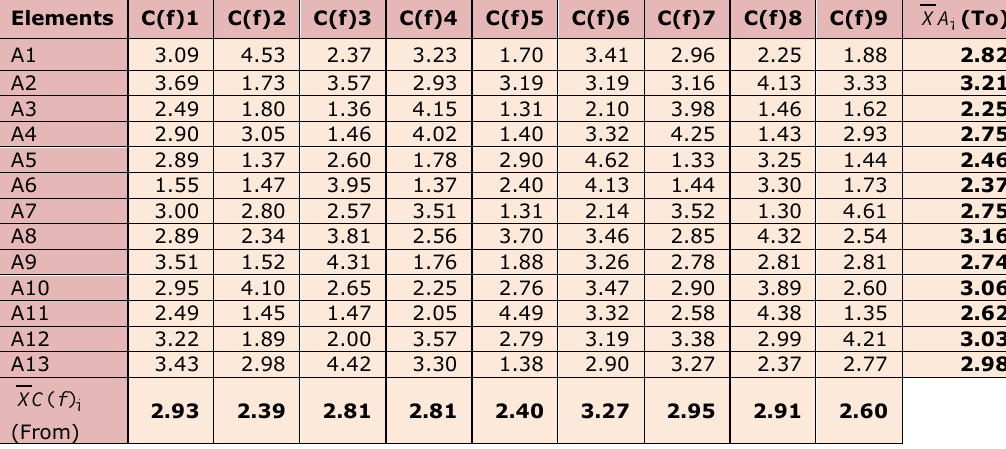
Table 2. Associations Matrix summary for the electronic tour guide design study